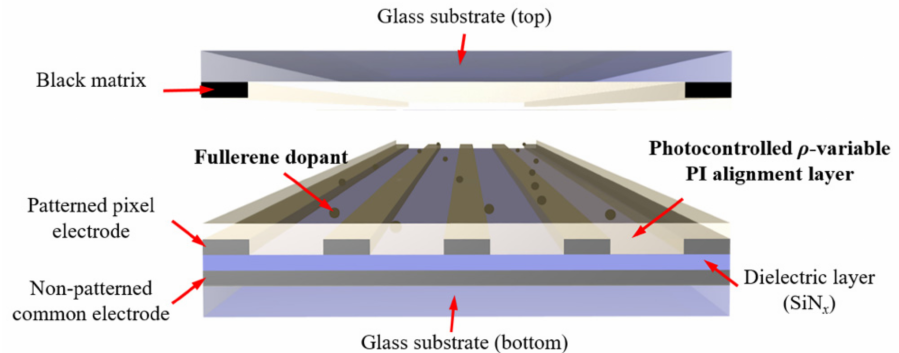
Figure 1. Cross-sectional device structure of the FFS n -LC mode with photocontrolled ρ -variable PI used as the LC alignment